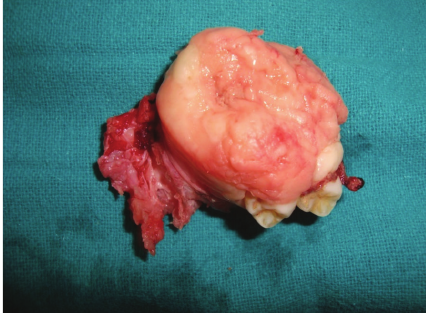
Figure 7: Resected tumor